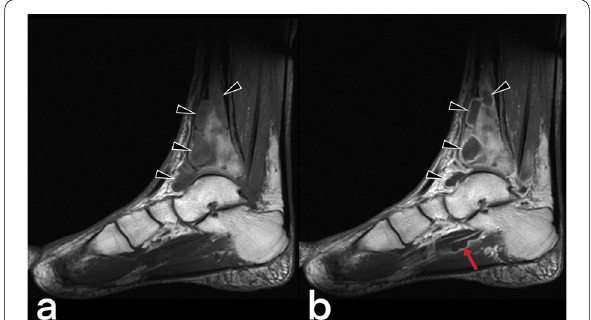
Fig. 52 MR images of a 59-year-old male. Pre-contrast ( a ) and postcontrast ( b ) T1 weighted images demonstrate intraosseous (arrowheads) and soft tissue abscesses (arrow) in the distal part of the tibia and plantar face of the foot